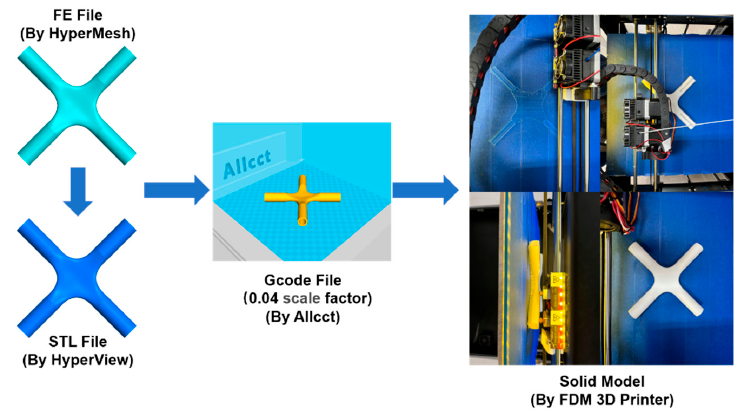
Figure 15. 3D printing technology of the generative joint.